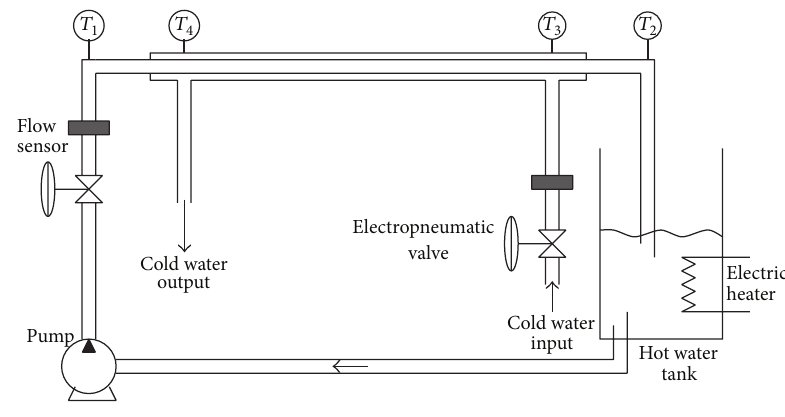
Figure 1: Heat exchanger